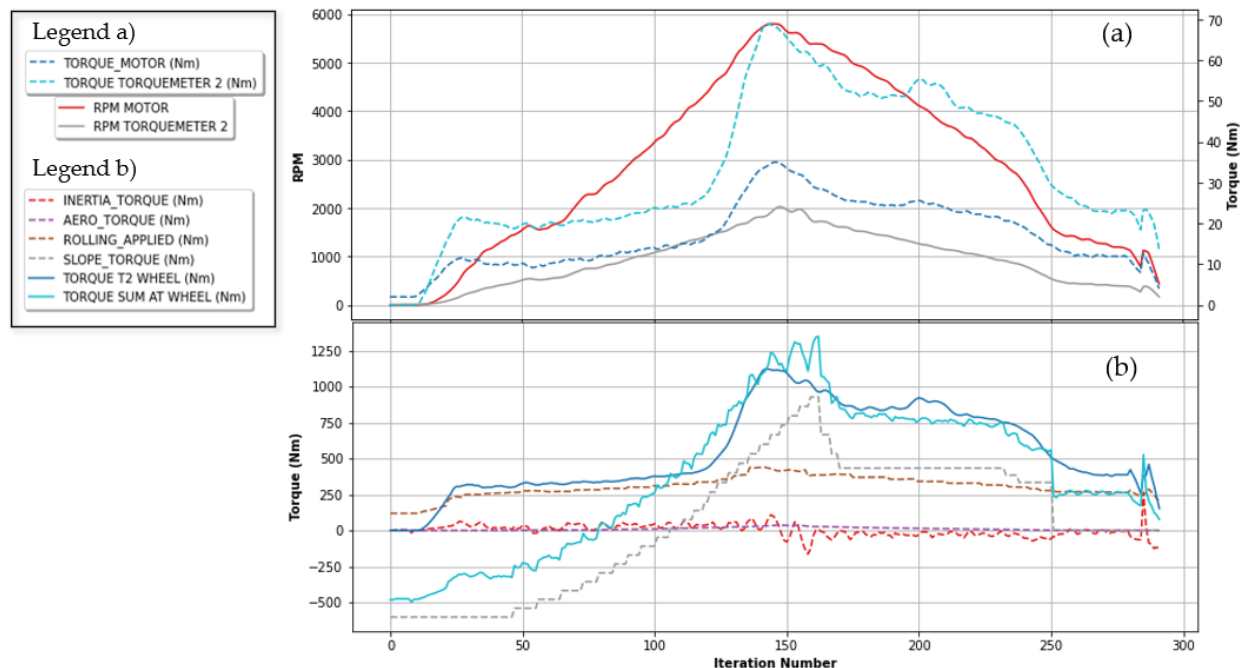
Figure 10. ( a ) Measured torque and RPM; ( b ) applied torques. From the torque and RPM values measured, power usage as show in Figure 11 is obtained. In it, solid lines (red, yellow, and gray colors) represent the electrical consumption measured by the current and voltage sensors, for the electrical power; and torque and RPM for torquemeters 1 (motor power) and 2 (mechanical power, which takes into account powertrain efficiencies). The dotted lines show the corrected torque considering the simulated dynamics; where the light blue line shows the real power used by the bus motor and the dark blue line the real power of the bus at the rim, after subtracting mechanical losses. In the downhill sections (beginning of this route) the power of the bus is lower than that measured by the sensors thanks to the descending slope contributing most of the torque required for vehicle acceleration.